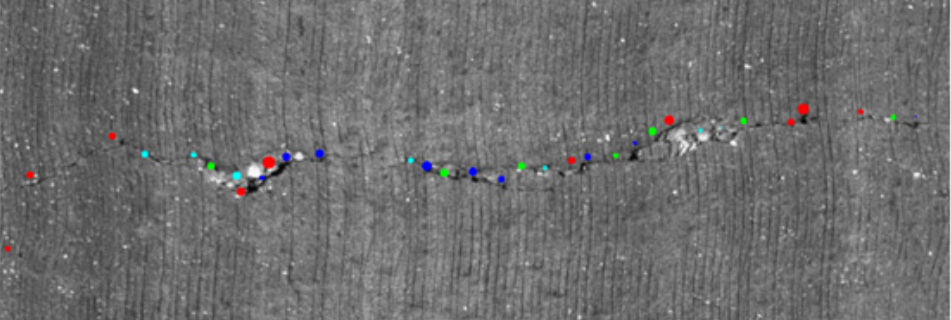
Figure 12. Seeds detection results. The color indicates the orientation. The thickness of the circle used to draw the seeds is directly proportional to the seeds